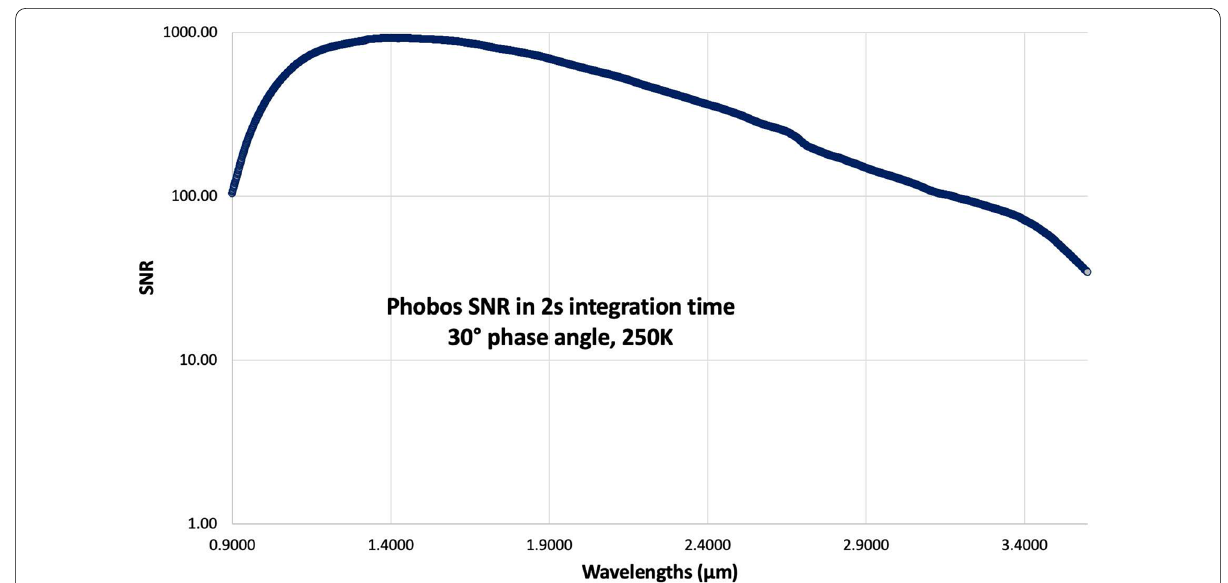
Fig. 18 Typical SNR profile for Phobos—QSO‑M in 2‑s integration